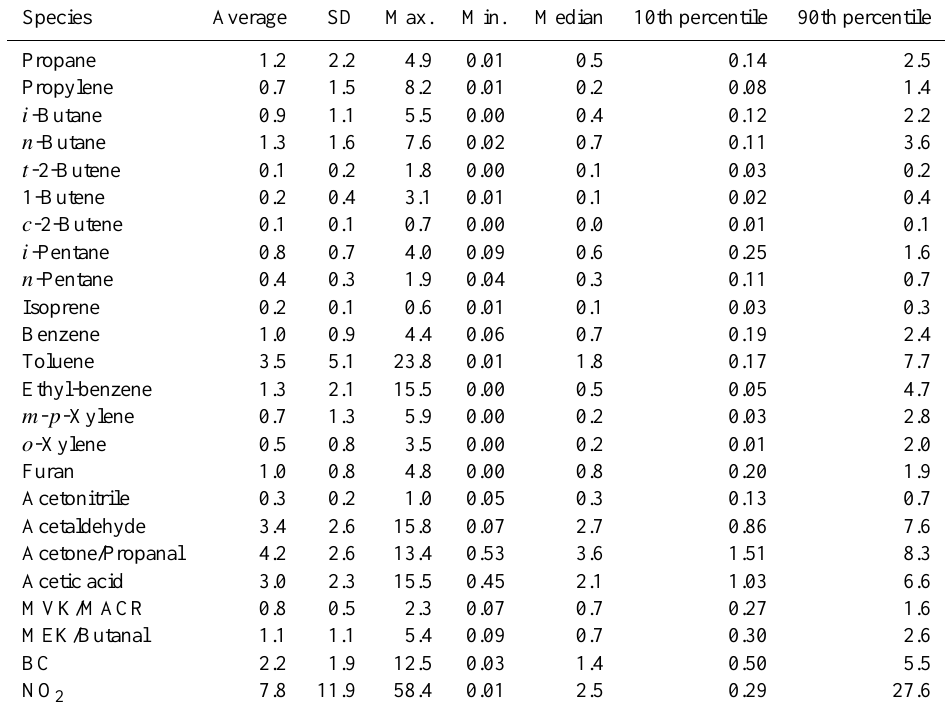
Table 1. Statistics on the mixing ratios of NMVOC species and NO 2 (in unit ofppbv), and mass concentration of BC (in unit of µgm − 3 ) during the field campaign